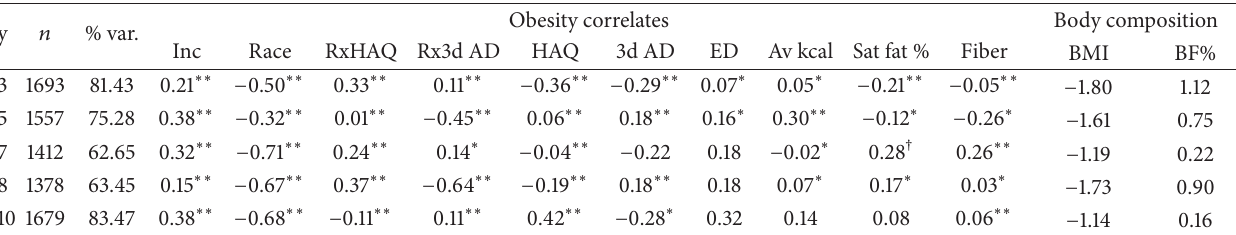
Table 2: Canonical correlation analysis evaluating health behaviors and confounders (obesity correlates) with body composition. Percent variance explained by first indices and first indices’ standardized canonical coefficients by visit year. Obesity correlates Body composition